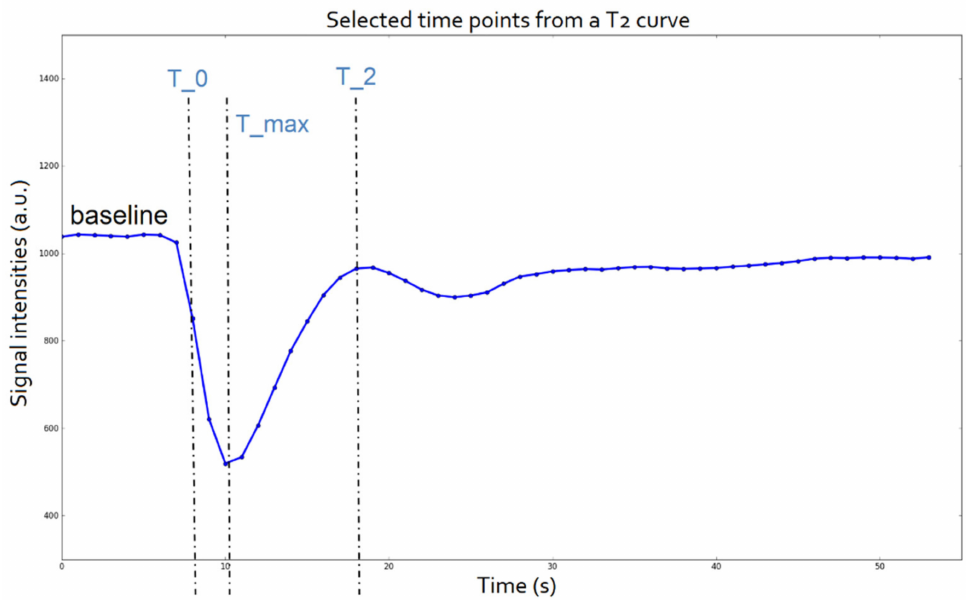
Figure 1. Time points of interest of a T2 mean signal intensity